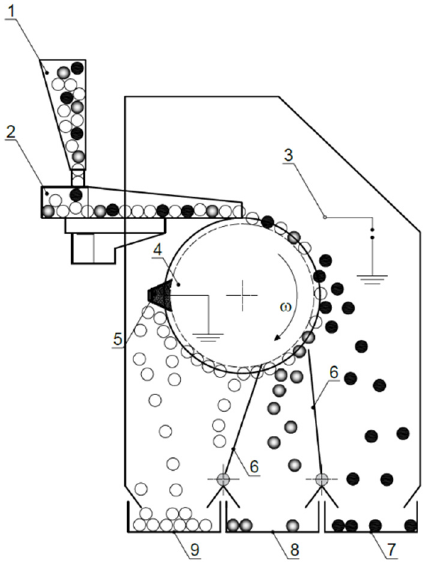
Figure 1. Diagram of the electrostatic separator: 1—feed container, 2—vibrating feeder, 3—electrode, 4—drum, 5—brush, 6—partition, 7—conductor container (concentrate), 8—container for complex grains folded with metals and nonmetals, and 9—nonconductor container (waste).